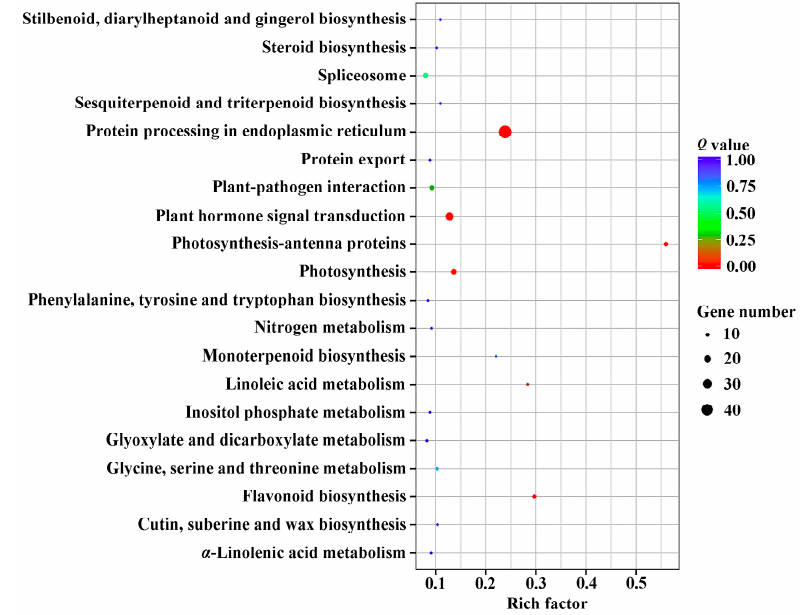
Figure 3. The statistics of Kyoto Encyclopedia of Genes and Genomes (KEGG) pathway enrichment involved in DEGs after GA 3 treatment in J. curcas . The Rich factor indicated the percentages of DEGs belong to the corresponding pathway. The sizes of bubble represent the number of DEGs in the corresponding pathway, and the colors of the bubble represent the enrichment Q value of the corresponding pathway.